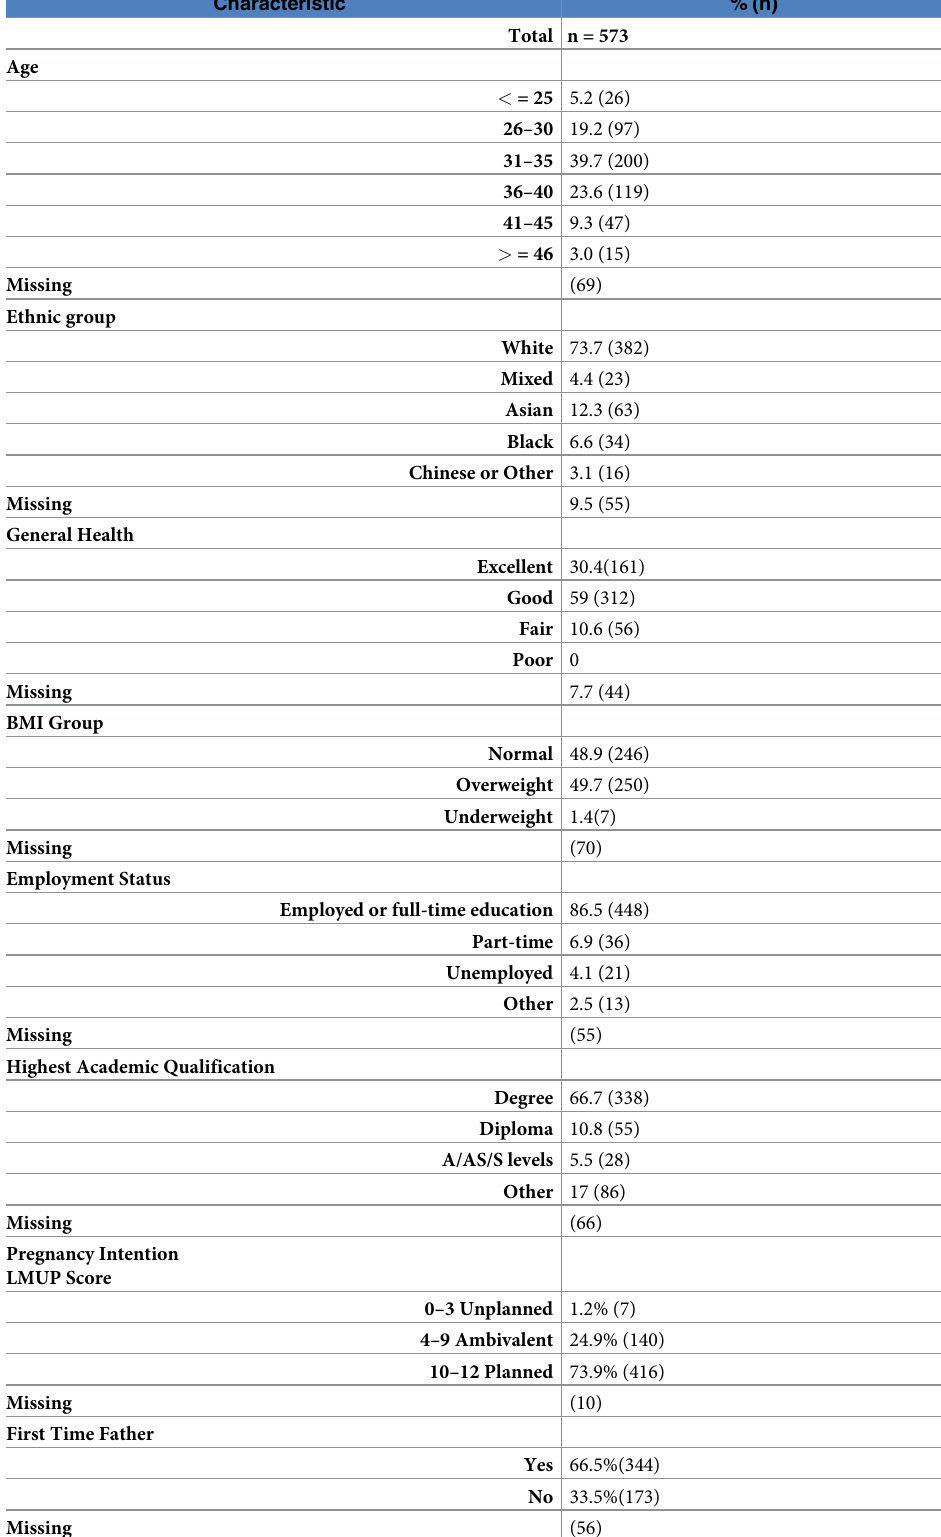
Table 1. Demographic characteristics and level of pregnancy